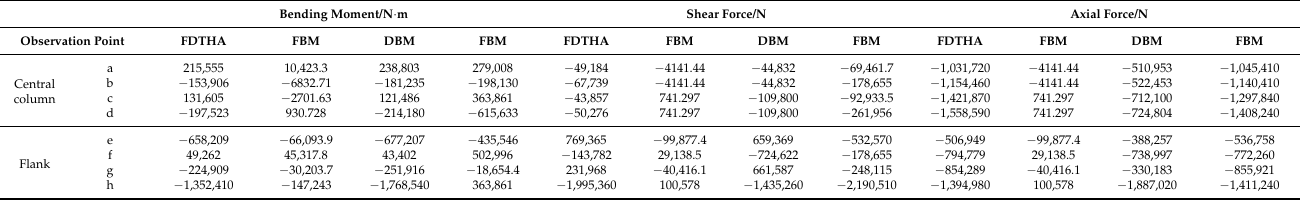
Table A4. Comparison of internal forces at control points of structures with different calculation